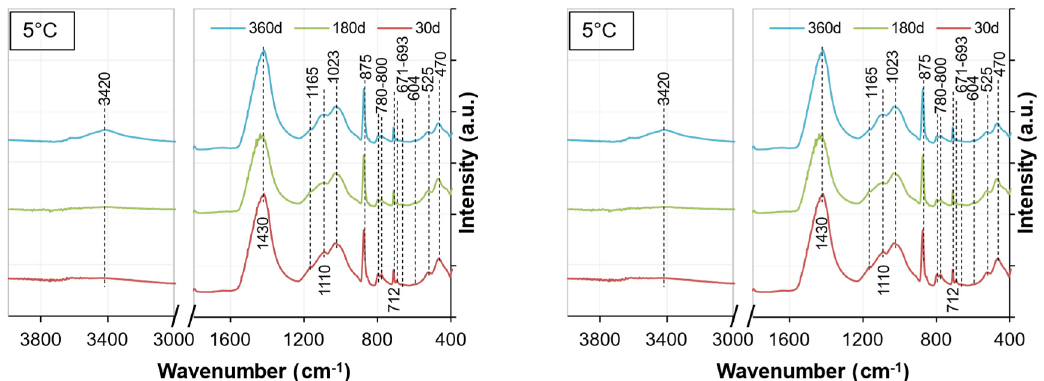
Figure 21. FTIR spectra of Sg + S + C + W2. Table 6. Interpretation of peak positions observed in FTIR spectra of soil stabilized with WPFA or cement.